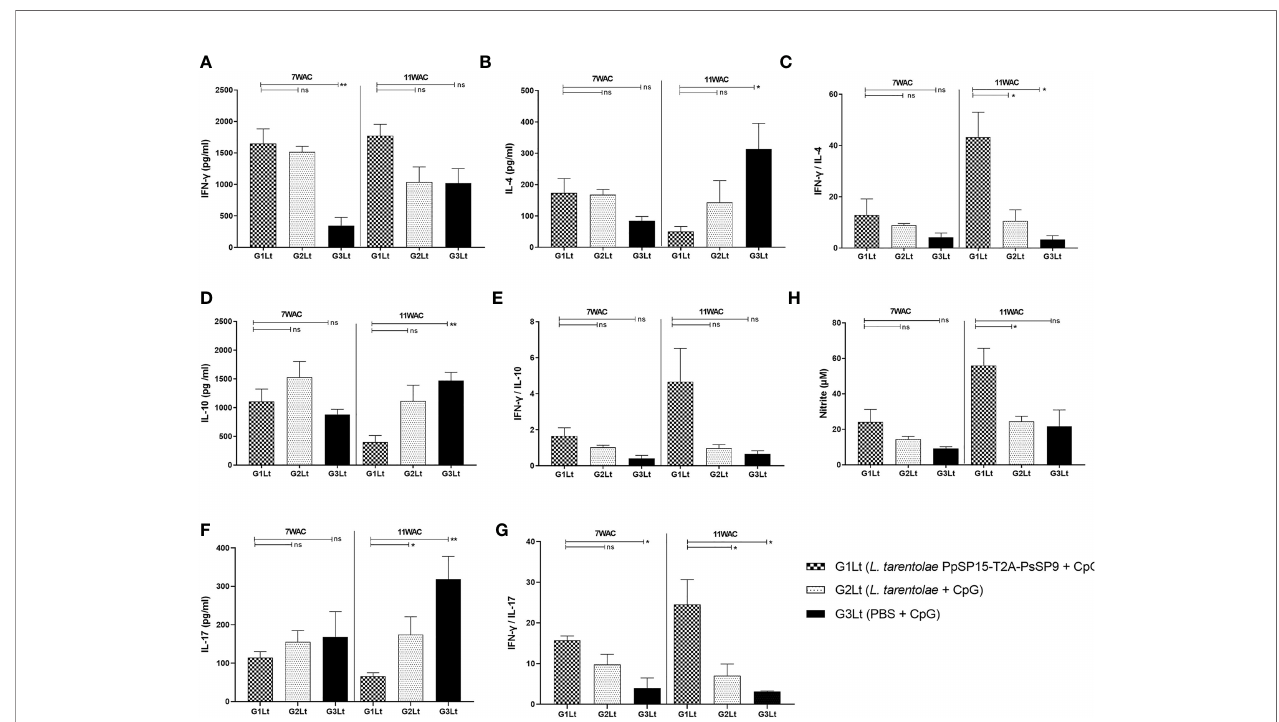
FIGURE 8 | Assessment of cytokines productions in vaccinated and control groups at post-infection with L. tropica + SGH Ph . sergenti . Following 7 th and 11 th weeks after challenge, all mice (n=3-4 per group) were sacri fi ced and splenocytes from each individual BALB/c mouse were re-stimulated by L. tropica F/T antigen. (A) IFN- g production, (B) IL-4 production, (C) IFN- g /IL-4 ratio, (D) IL-10 production, (E) IFN- g /IL-10 ratio, (F) IL-17 production, (G) IFN- g /IL-17 ratio, (H) Nitric oxide (NO) production. The results are presented as mean ± SE in pg/ml for cytokines or in µm for NO. Data are representative of two independent experiments. Student t-test was used for statistical analysis (* p < 0.05; ** p < 0.01; ns, non-signi fi